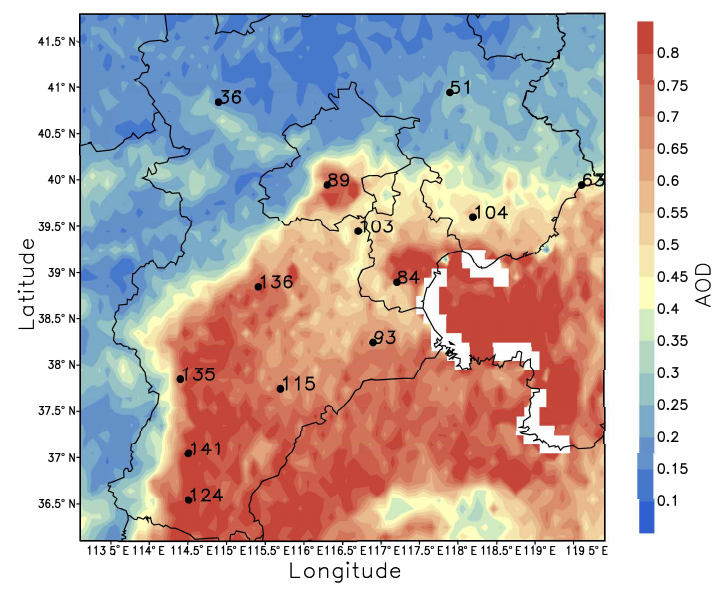
Figure 7. Distribution of the annual mean values of AOD from December 2013 to November 2014 in the NCP. The PM 2 . 5 concentrations of the 13 observation sites were also marked beside each station. The major sites in the northern NCP (BJ and TJ) and southern Hebei (SJZ, XT and HD) are enclosed by white